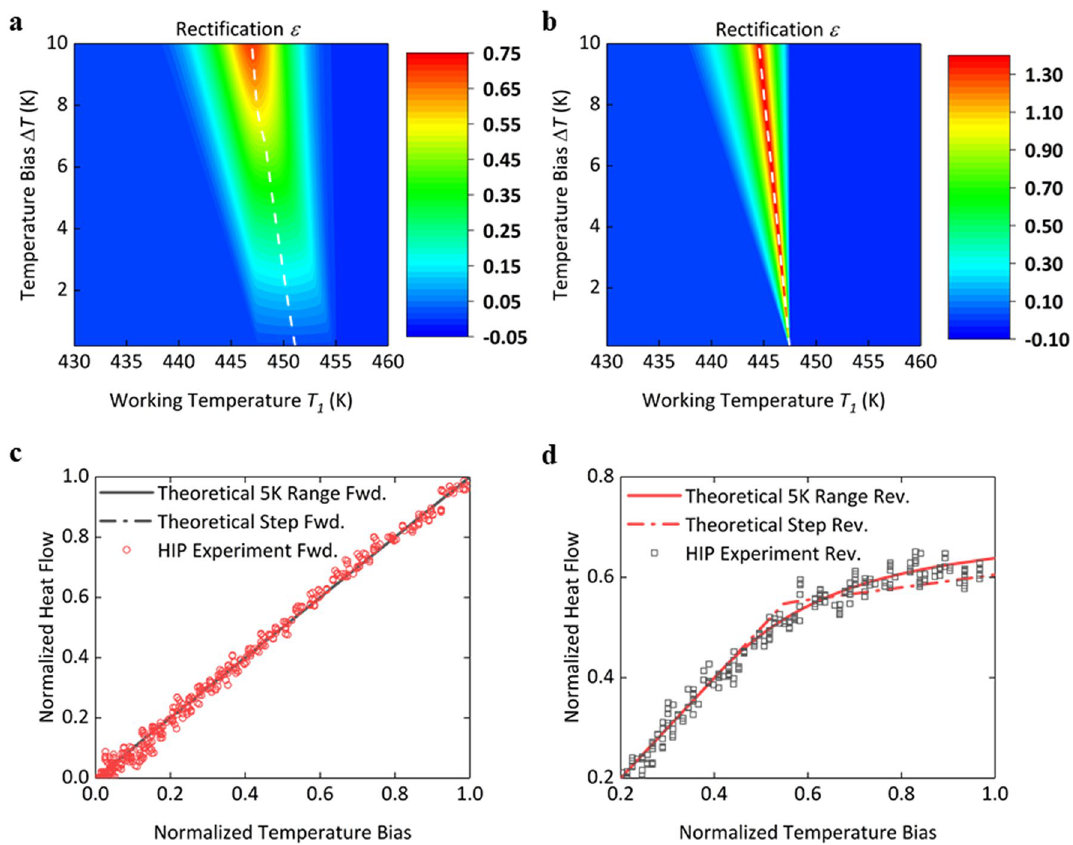
Figure 3. Rectification of the HI-P PE nanofiber junction as a function of working temperature T 1 and temperature bias Δ T with ( a ) the 7.5 K temperature range of phase transition of the pristine segment, and ( b ) the step-function phase transition. The white dashed line marks the local maximum rectification ε max_local at a certain temperature bias Δ T . The length fraction of irradiation is 5%. ( c ) and ( d ) Comparison of heat flow curves with our previous experimental data, for the forward and reverse biases, respectively. The experimental data are measured at working temperature 435 K with a ~ 9 K temperature bias. The phase transition model is modified with phase transition range from 435 to 440 K, based on our experimental data of the pristine PE